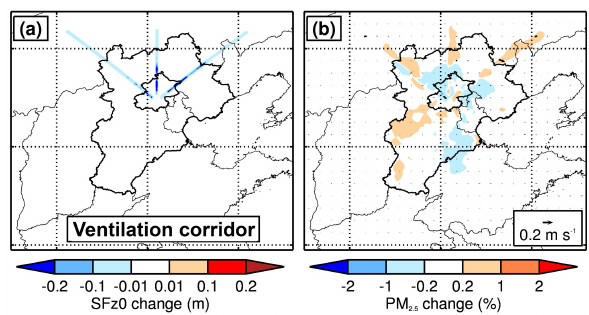
Figure 8. Impacts of an artificial large ventilation corridor system on (a) SFz0 and (b) average near-surface PM 2 . 5 mass concentra- tions from 1 December 2013 to 31 January 2014, along with the wind field (black